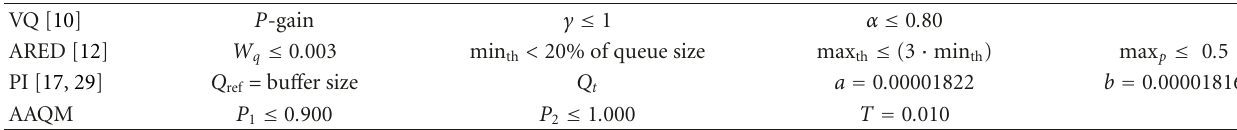
Table 2: lists of control parameters for each